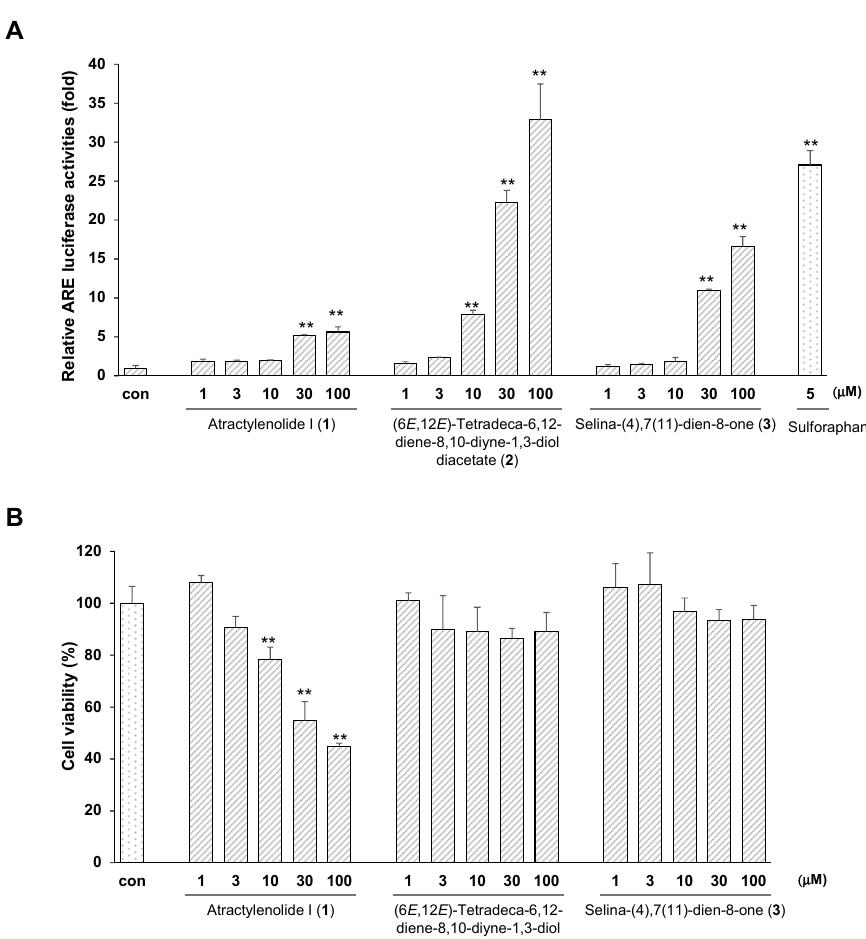
Figure 4. ARE luciferase activities ( A ) and cytotoxicity ( B ) of isolated compounds 1 – 3 in HepG2 cells. The relative ARE luciferase activities were measured in the lysates of HepG2 cells that were stably transfected with pGL4.37 after exposure to 1–100 µ M of each compound for 12 h. Cell viability was measured by the MTT assay. Data are presented as means ± S.E. ( n = 5). **, p < 0.01 (compared with the vehicle-treated control).